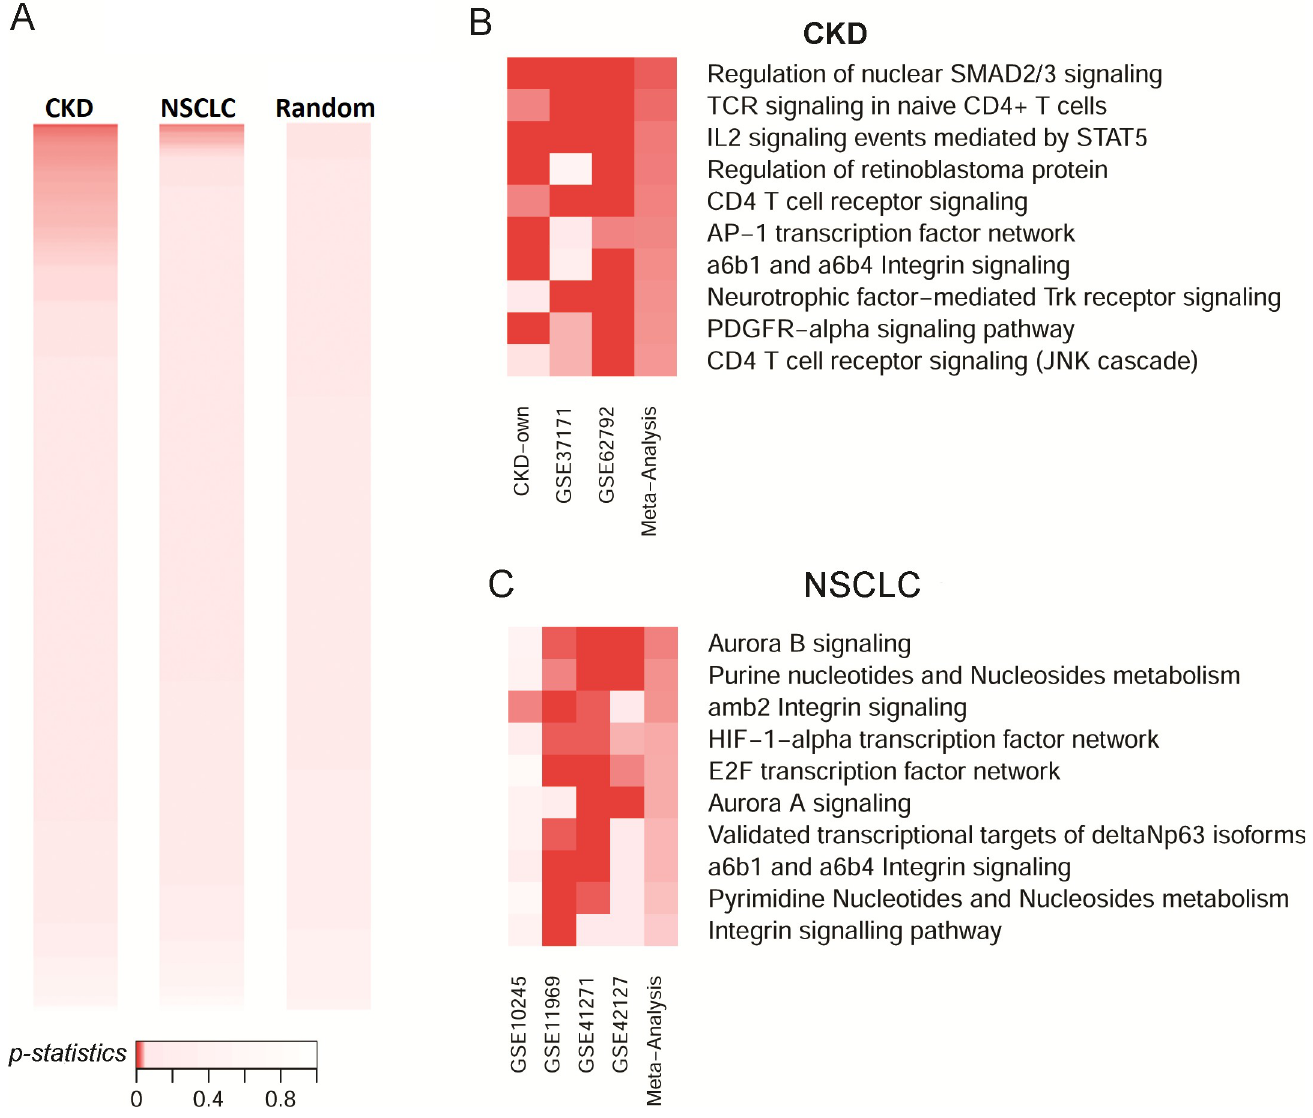
Fig 2. Case studies and specificity analysis. A) Meta-analysis p -statistics from the CKD and NSCLC case studies as well as 100 random gene sets. B) Top 10 significant pathways identified in CKD. C) Top 10 significant pathways identified in NSCLC. For both case studies, p -statistics from all individual datasets and the meta-analysis are displayed in a